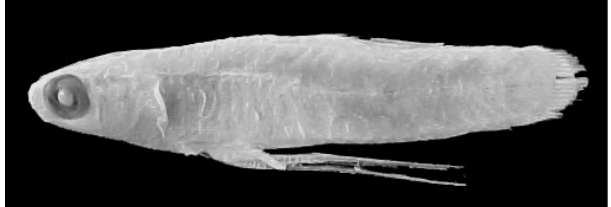
Fig. 3. Phalloptychus eigenmanni . FMNH 55877, rio Catu, Alagoinhas, Bahia, Brazil, paratype, immature male, 15.8 mm SL.